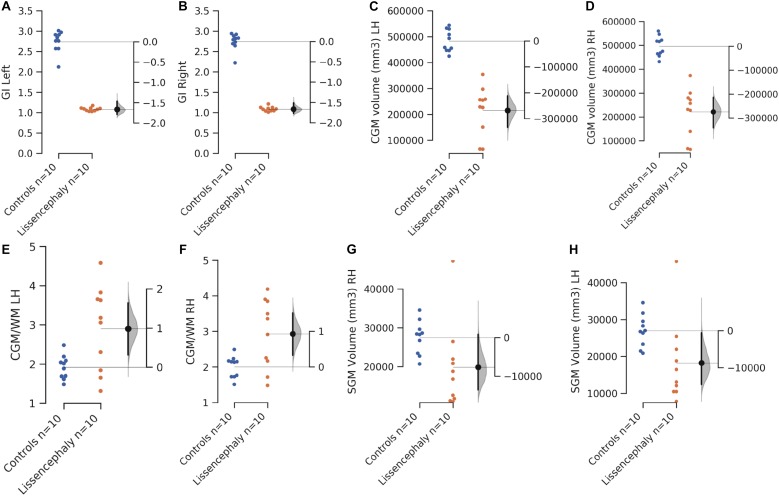
Scatterplots showing the comparison of the mean left and right hemispheric gyrification index (A,B), CGM volume (C,D), CGM/WM volume ratio (E,F), and SGM volume (G,H) between controls (blues) and patients with lissencephaly (orange). The y-axis on the left side of each scatterplot shows the measured values. The shorter y-axis on the right is to show the difference of the means. The filled gray curve on the right of each scatterplot indicates the complete distribution of the effect size (difference of the means, Δ). The black line on the right of each scatterplot illustrates the 95% confidence interval of the Δ.